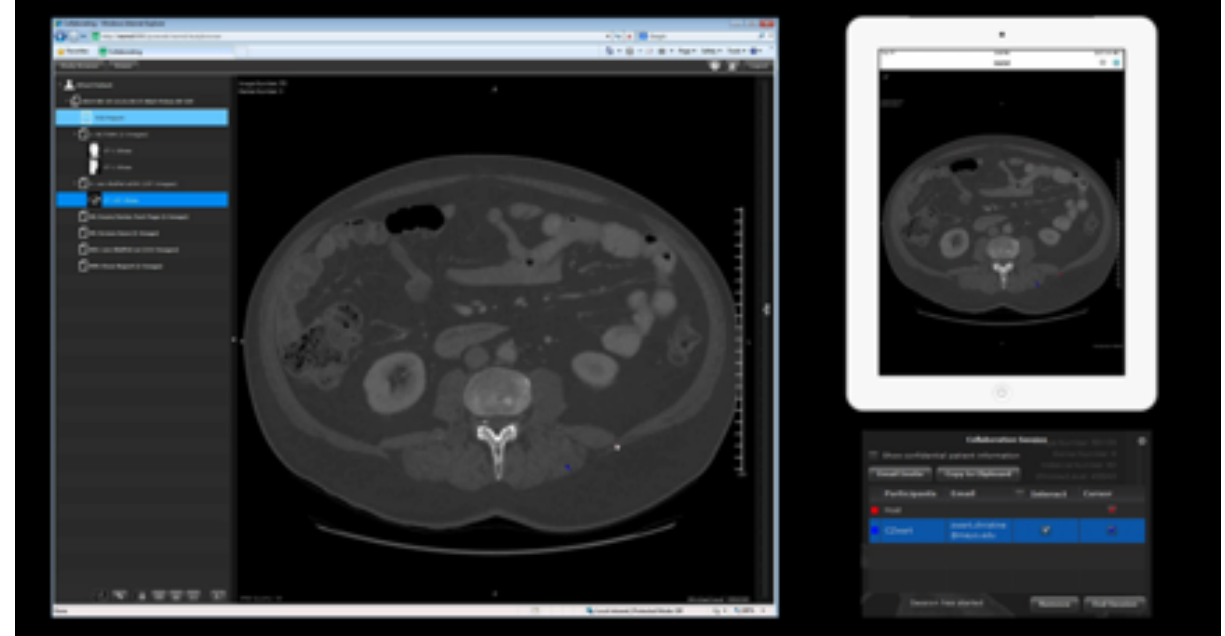
Figure 1. Overview of the ResMD interface and collaboration feature. A single ResMD session running simultaneously: in a desktop web browser (left) and as an application on an Apple iPad (top right). Interactions performed in either view are displayed interactively on both. Collaboration sessions are controlled via a collaboration window (bottom right). The collaboration window allows the “controller” to send invitations (via email), monitor who has joined the session, control the degree of interaction allowed by each user, and limit the display of patient